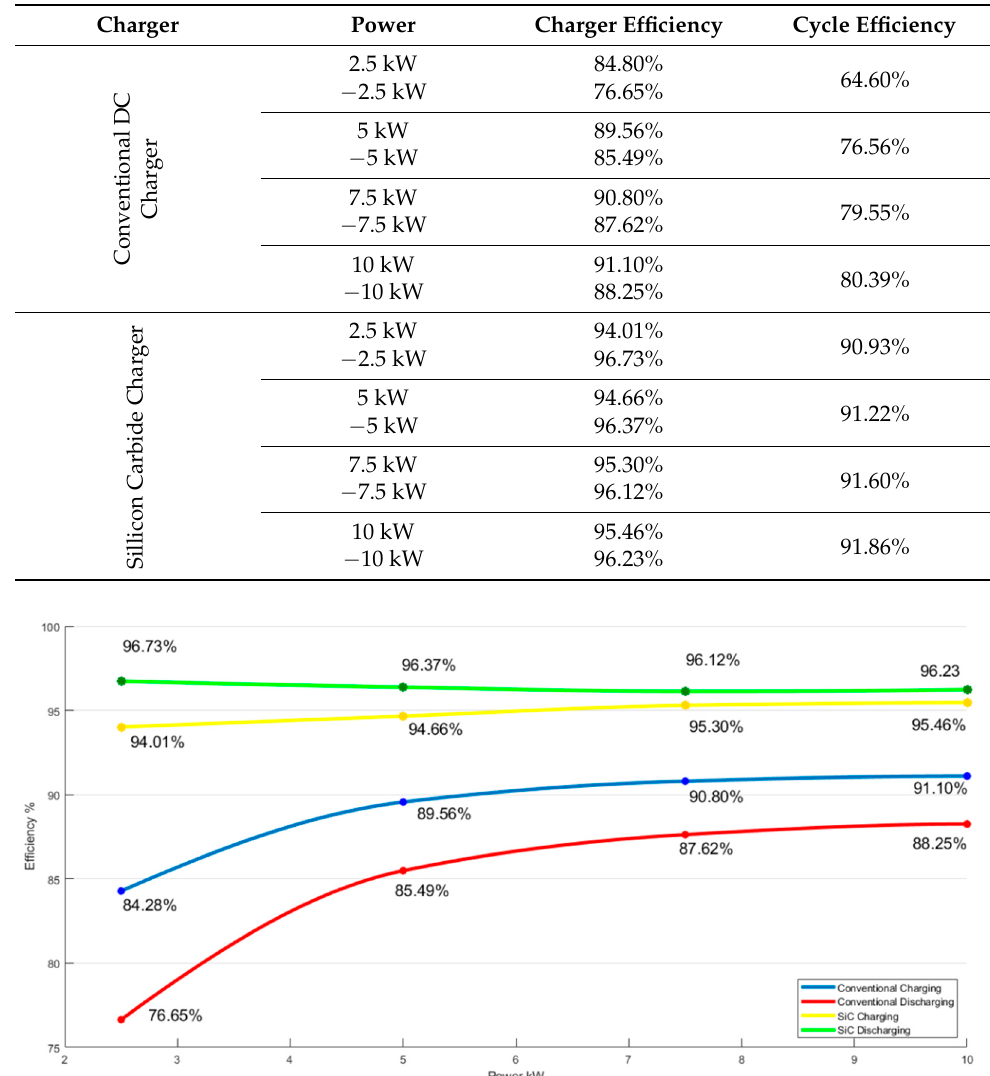
Table 5. Chargers and Cycle Efficiencies.